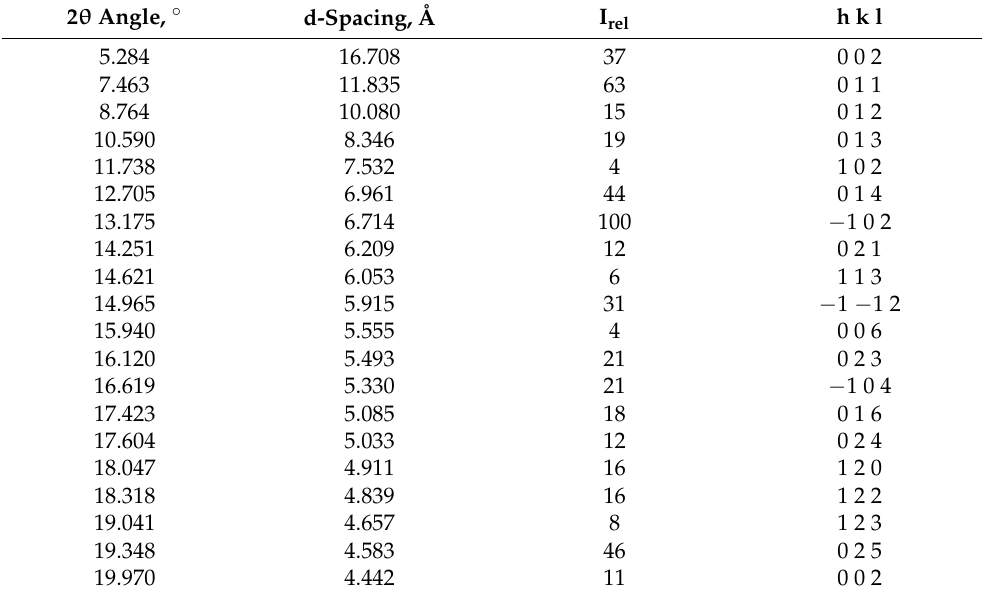
Table 12. List of observed 2 θ angles, d-spacings, and relative intensities, jointly with reflection indices, for Eltrombopag NMP2.